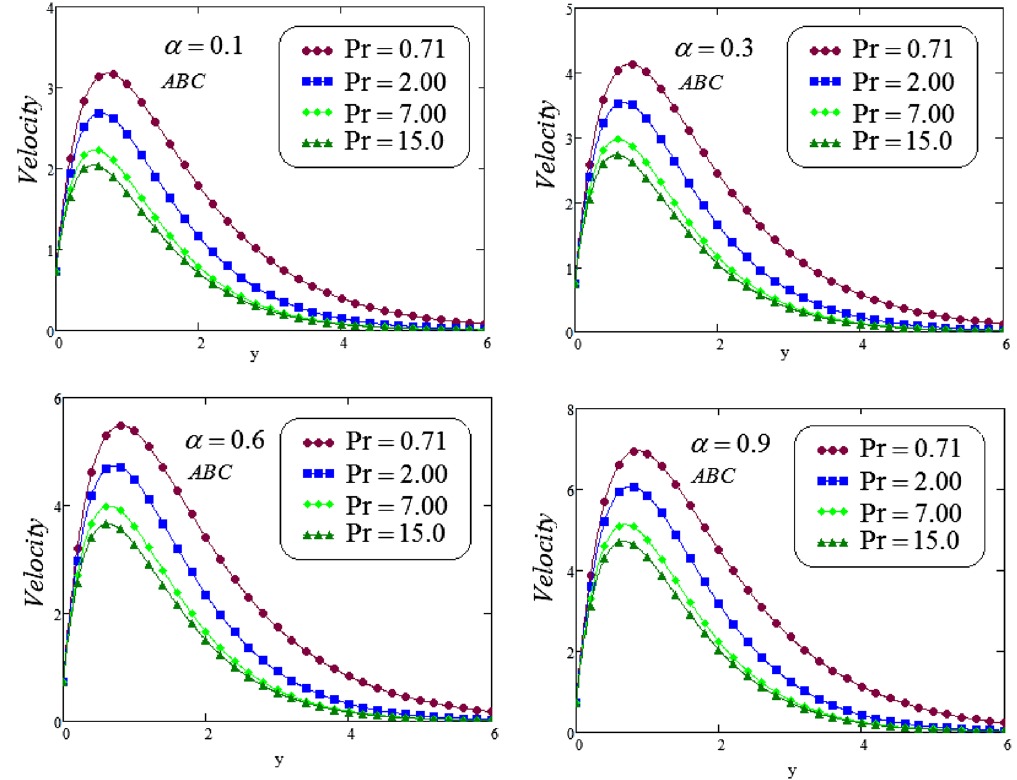
Figure 11. Representation of second grade fluid velocity via ABC for distinct values of Pr